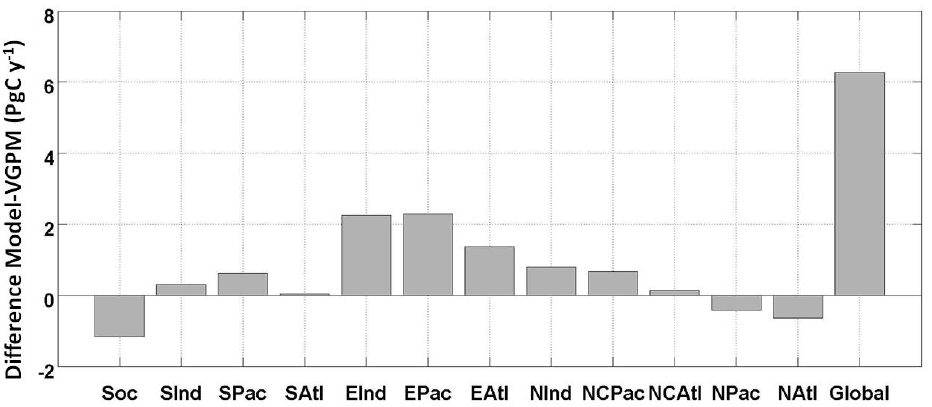
Figure 4. Global relative contributions of the four phytoplankton groups in NOBM to total primary production averaged over the period from 1998 to 2011. See Table 1 for a list of